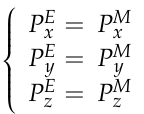
Figure 22. Flowchart of the distance criterion.